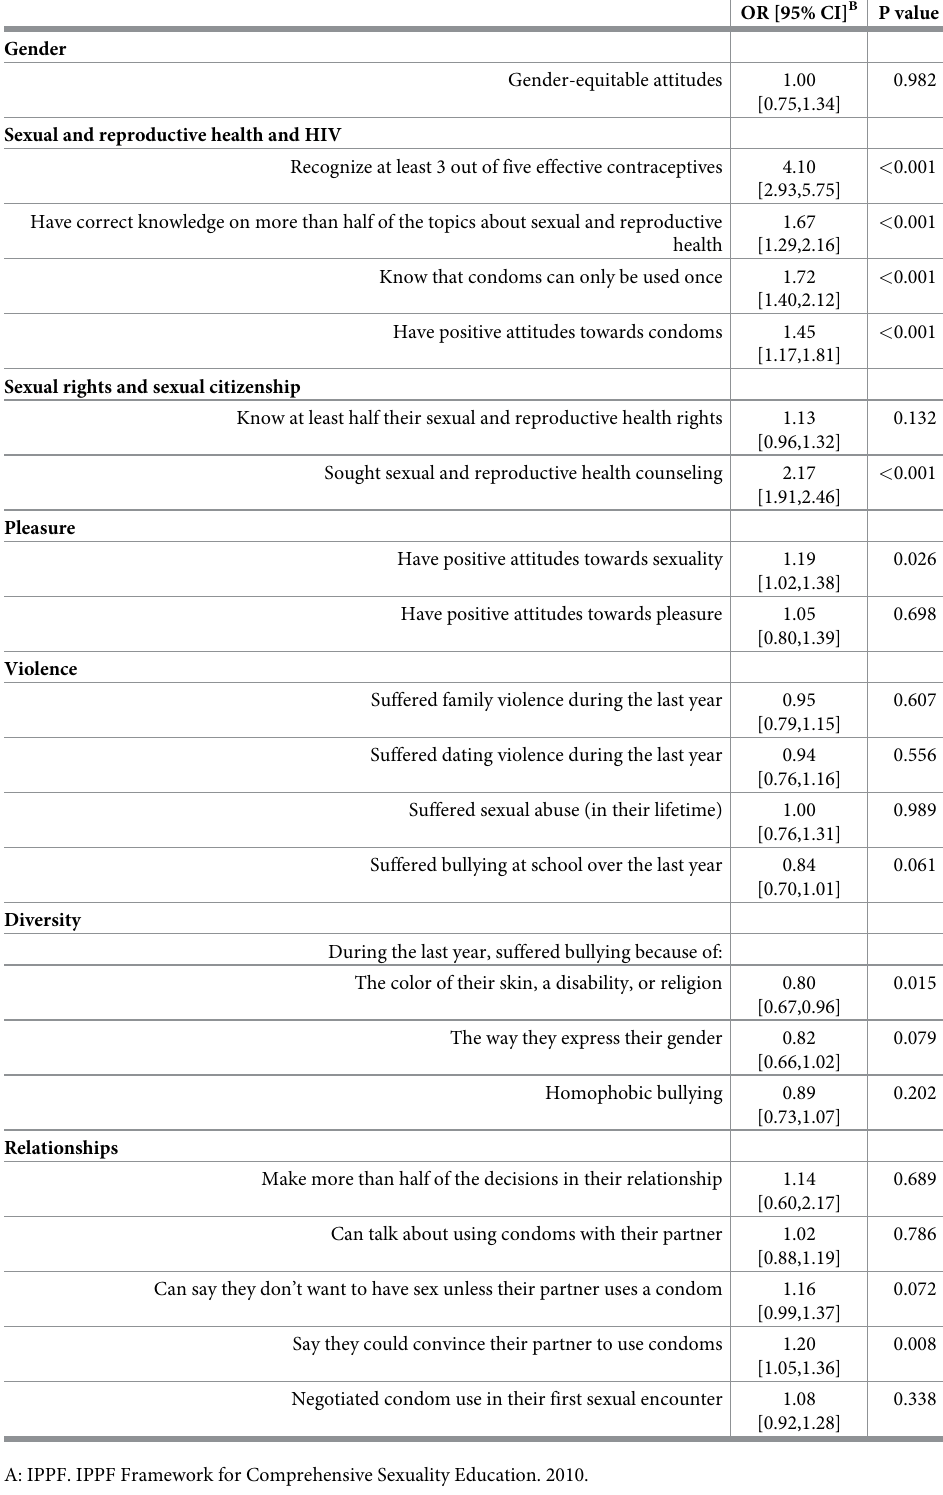
Table 6. Association between sexual and reproductive health outcomes and CSE coverage according to the IPPF framework. A Mexico